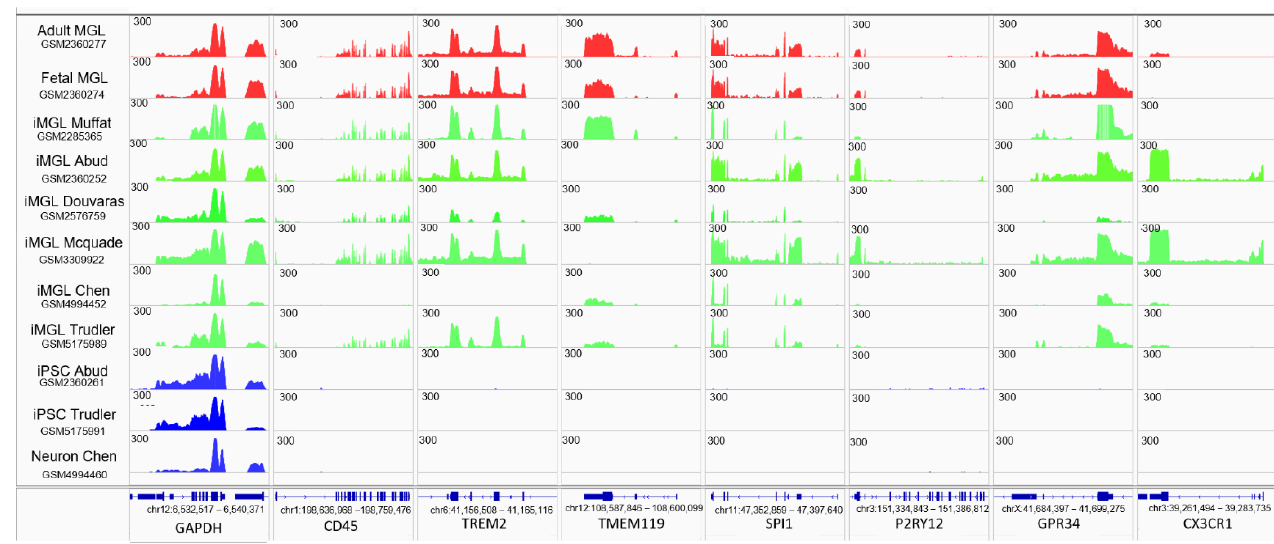
Figure 2. RNA-sequencing read coverage on microglial specific gene loci. Datasets corresponding to control in vivo microglia samples (adult and fetal cells) are shown in red, induced microglia-like (iMGL) datasets associated with each of the studied protocols are shown in green, and a composed negative control corresponding to the IPSC and neurons is shown in blue. To enhance their comparability, the read count amplitude for all samples has been set to